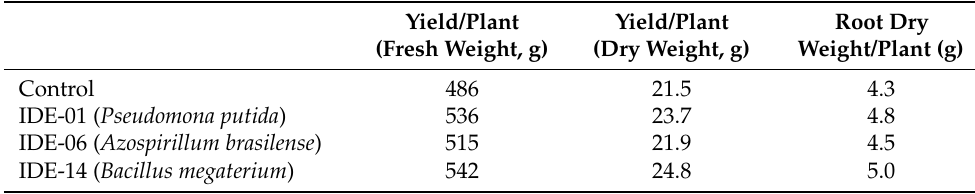
Table 2. Yields obtained in the IDEAGRO field experiment with lettuce.